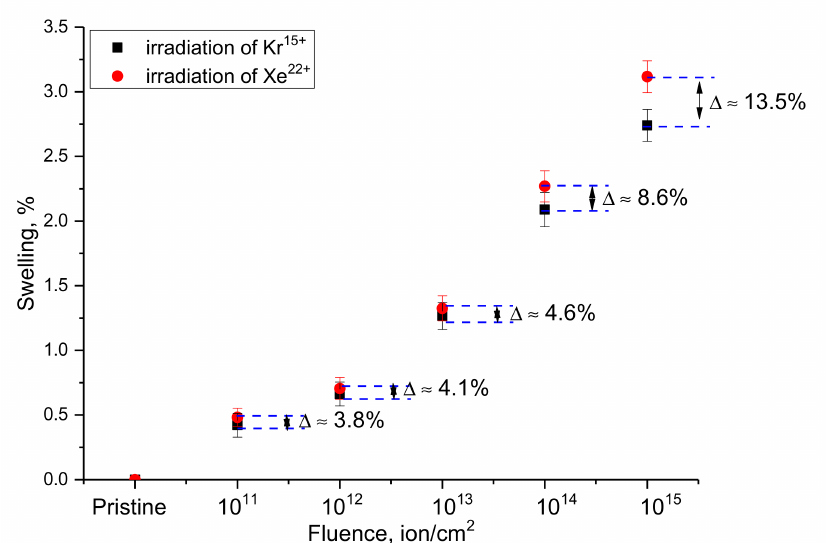
Figure 6. Results of the change in the crystal lattice volume depending on the irradiation fluence (the ∆ value reflects the difference (%) in the swelling value in the case of irradiation with different ions at the same irradiation